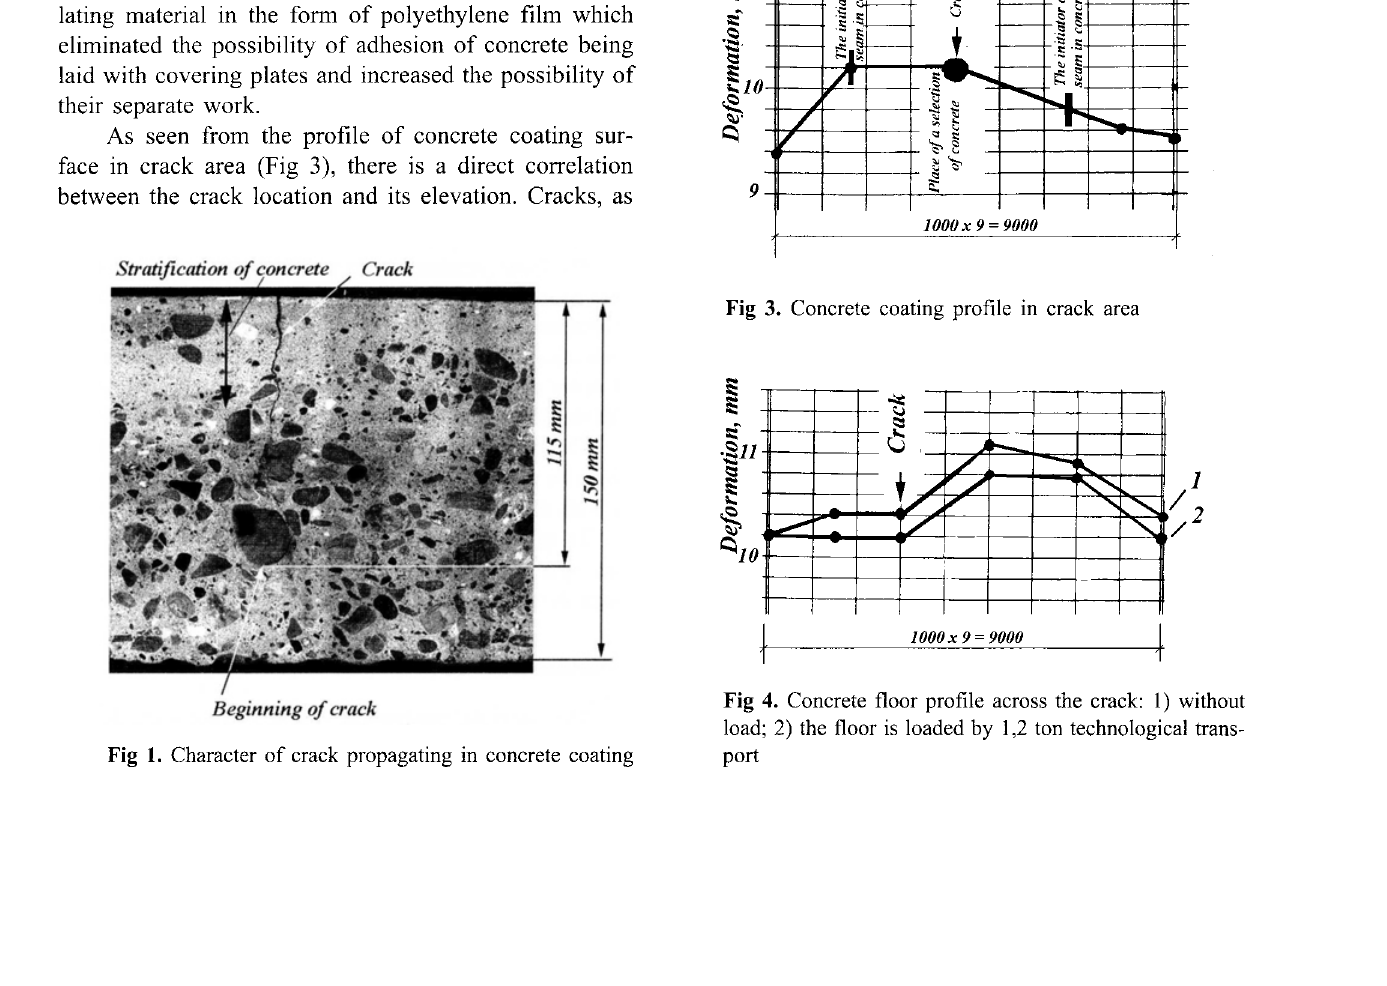
Fig 4. Concrete floor profile across the crack: 1) without load; 2) the floor is loaded by 1,2 ton technological trans